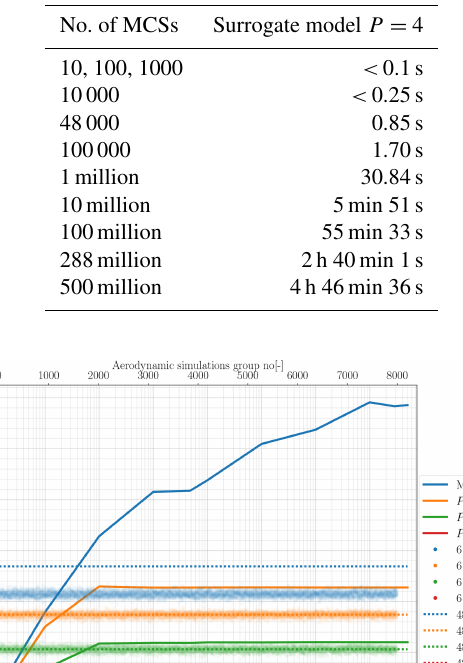
Table 4. Computational time to run MCSs on the surrogate models with polynomial order 4.